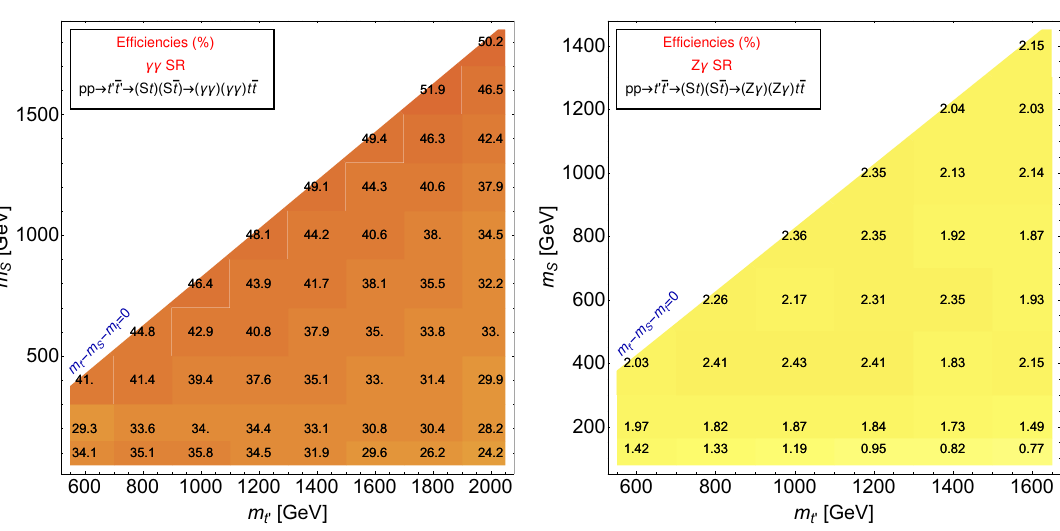
one to compute the expected total number of events via eq. (5.2) in the following